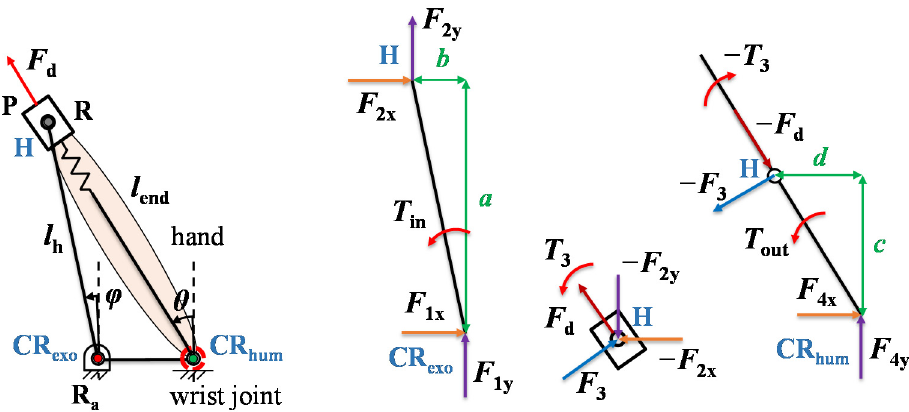
Figure 9. Free body diagram of the wrist robot.